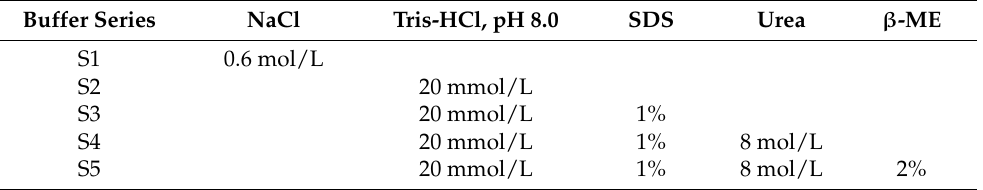
Table 1. The five different buffers used to measure the solubility of the